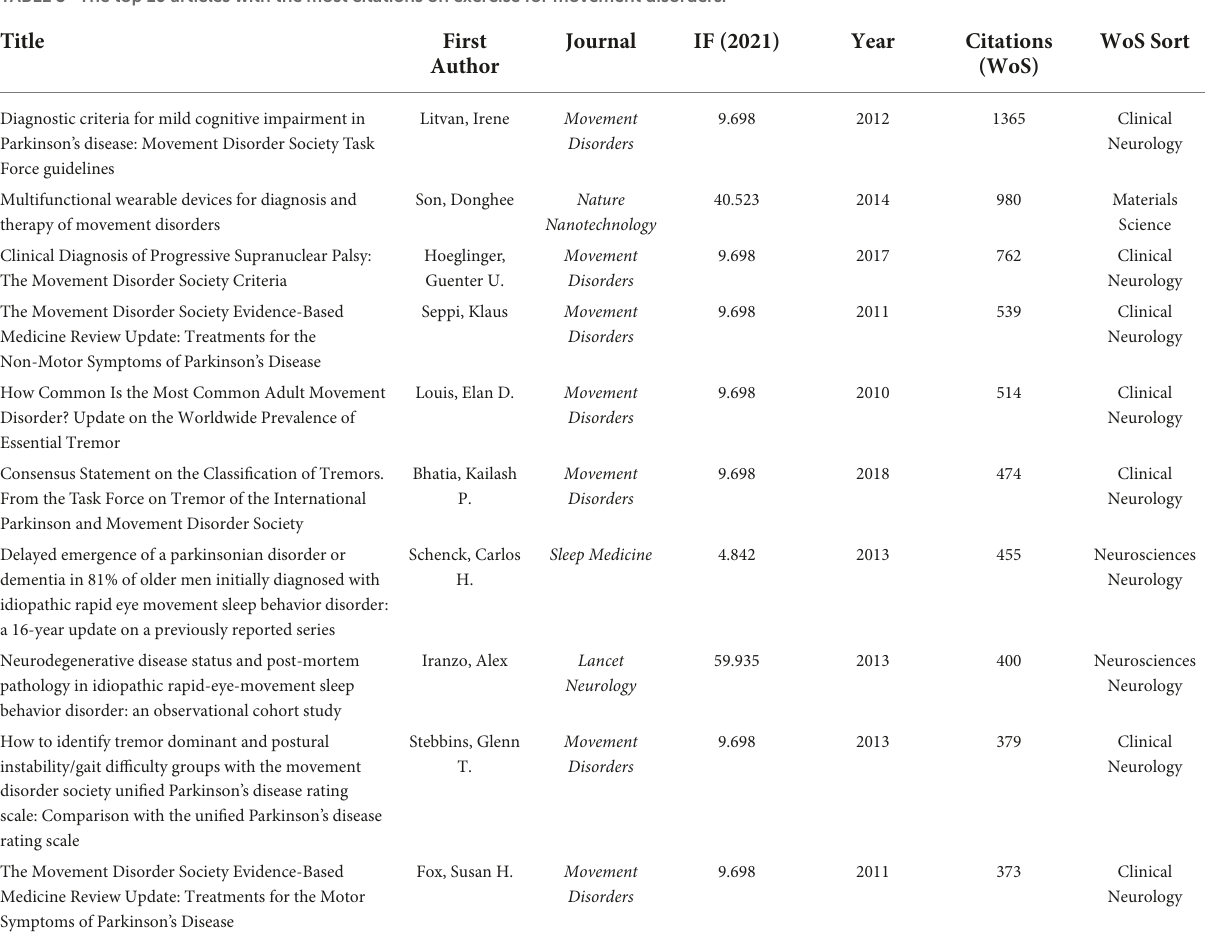
TABLE 3 The top 10 articles with the most citations on exercise for movement